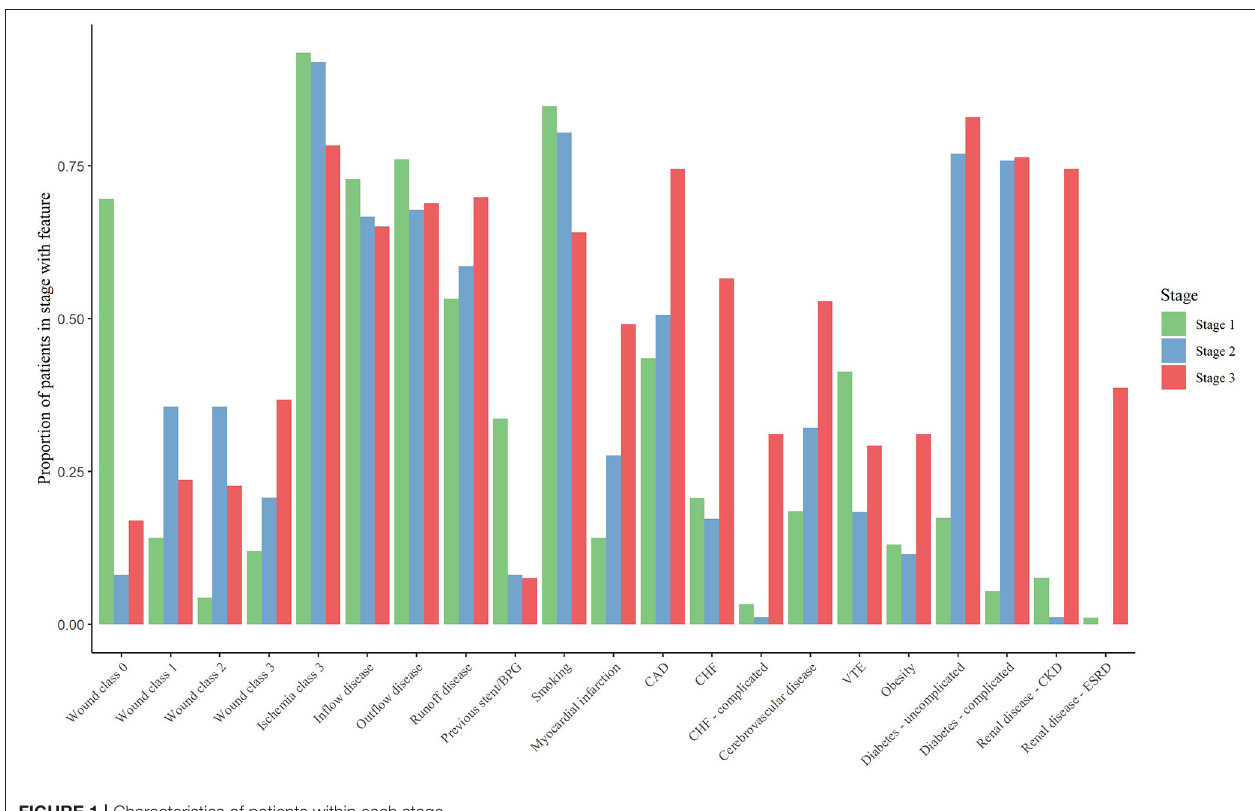
FIGURE 1 | Characteristics of patients within each stage.